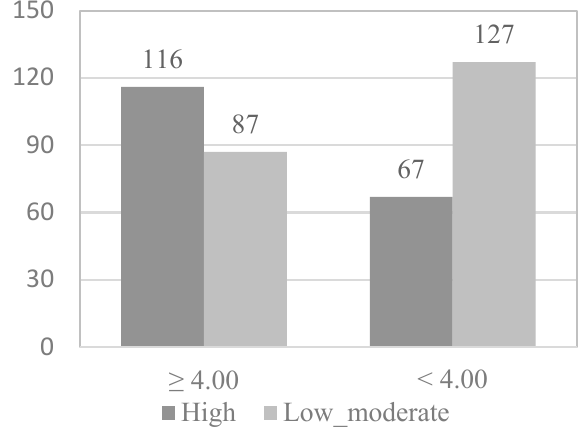
Figure 1. Functional skills physical activity level.